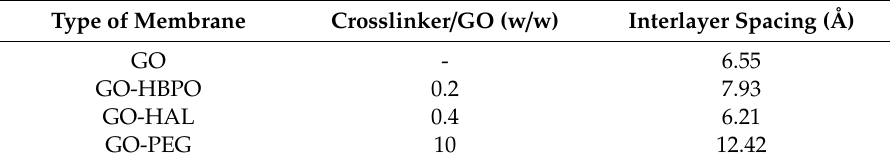
Table 1. Characteristics of the four types of supported graphene oxide (GO) membranes used in this